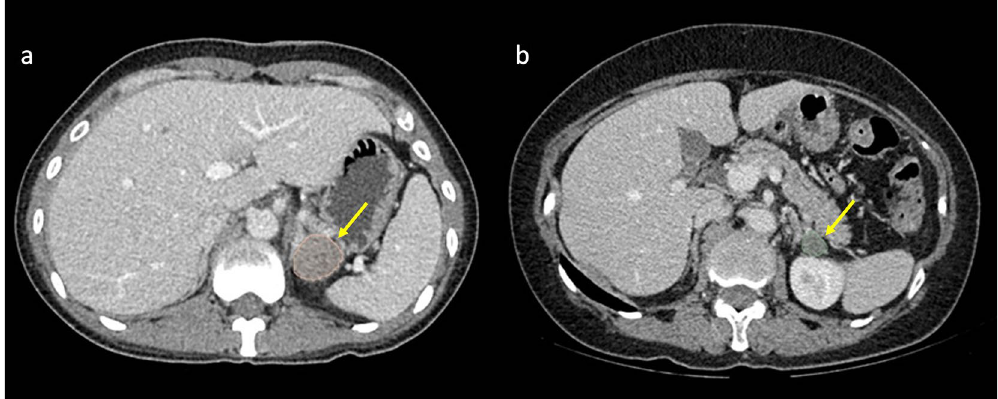
Figure 4. Adrenal nodule segmentation. ( a ) A 38-year-old female with primary aldosteronism refractory to medical treatment for hypertension. Abdominal CT showed a left adrenal nodule (arrow), and clinical success was achieved after laparoscopic adrenalectomy. ( b ) A 64-year-old female diagnosed with essential hypertension with a left adrenal nodule